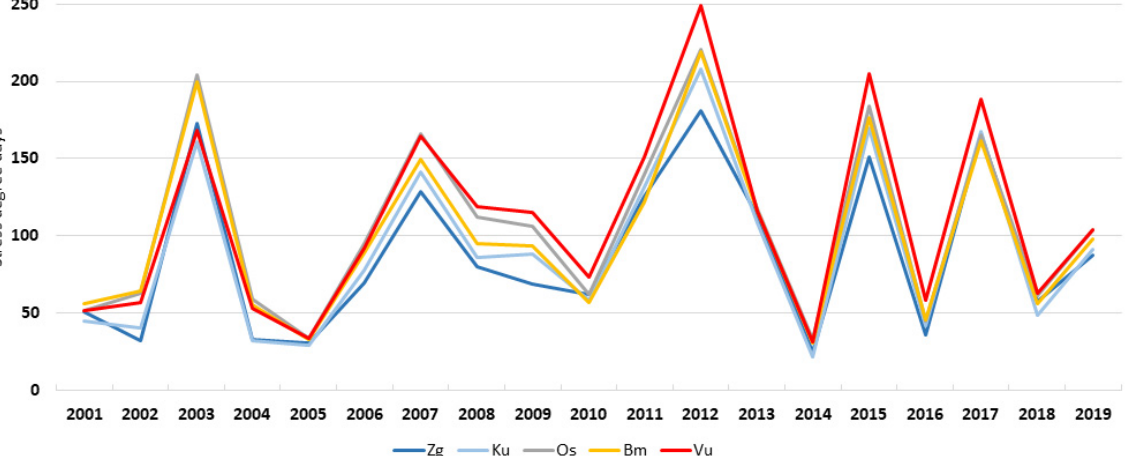
Figure 2. Stress Degree Days (SDD) for five locations in the continental part of Croatia in the two-decade period from 1999 to